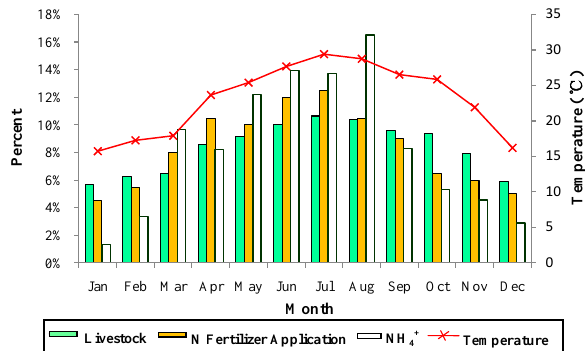
Fig. 7. Spatial distributions of total NH 3 emissions in the PRD region.